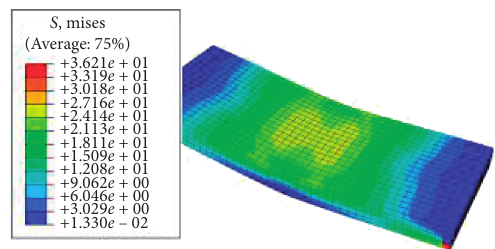
Figure 26: Stress cloud chart of the concrete under ultimate load.